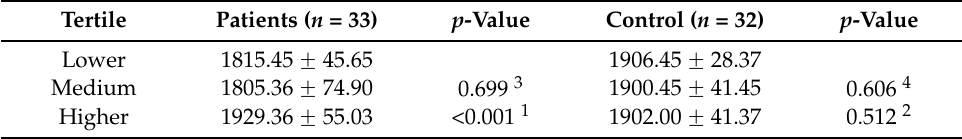
Table 5. Quantitative ultrasound (QUS) figures based in the calcium intake tertile.